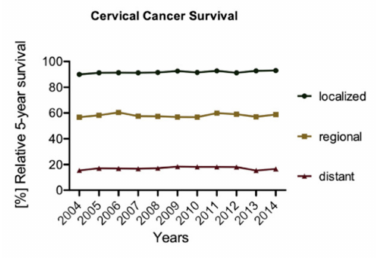
Figure 2. Summary of relative five-year survival from 2004 to 2014. Each data point corresponds to the percentage of patients alive five years after diagnosis (data extracted from the SEER program